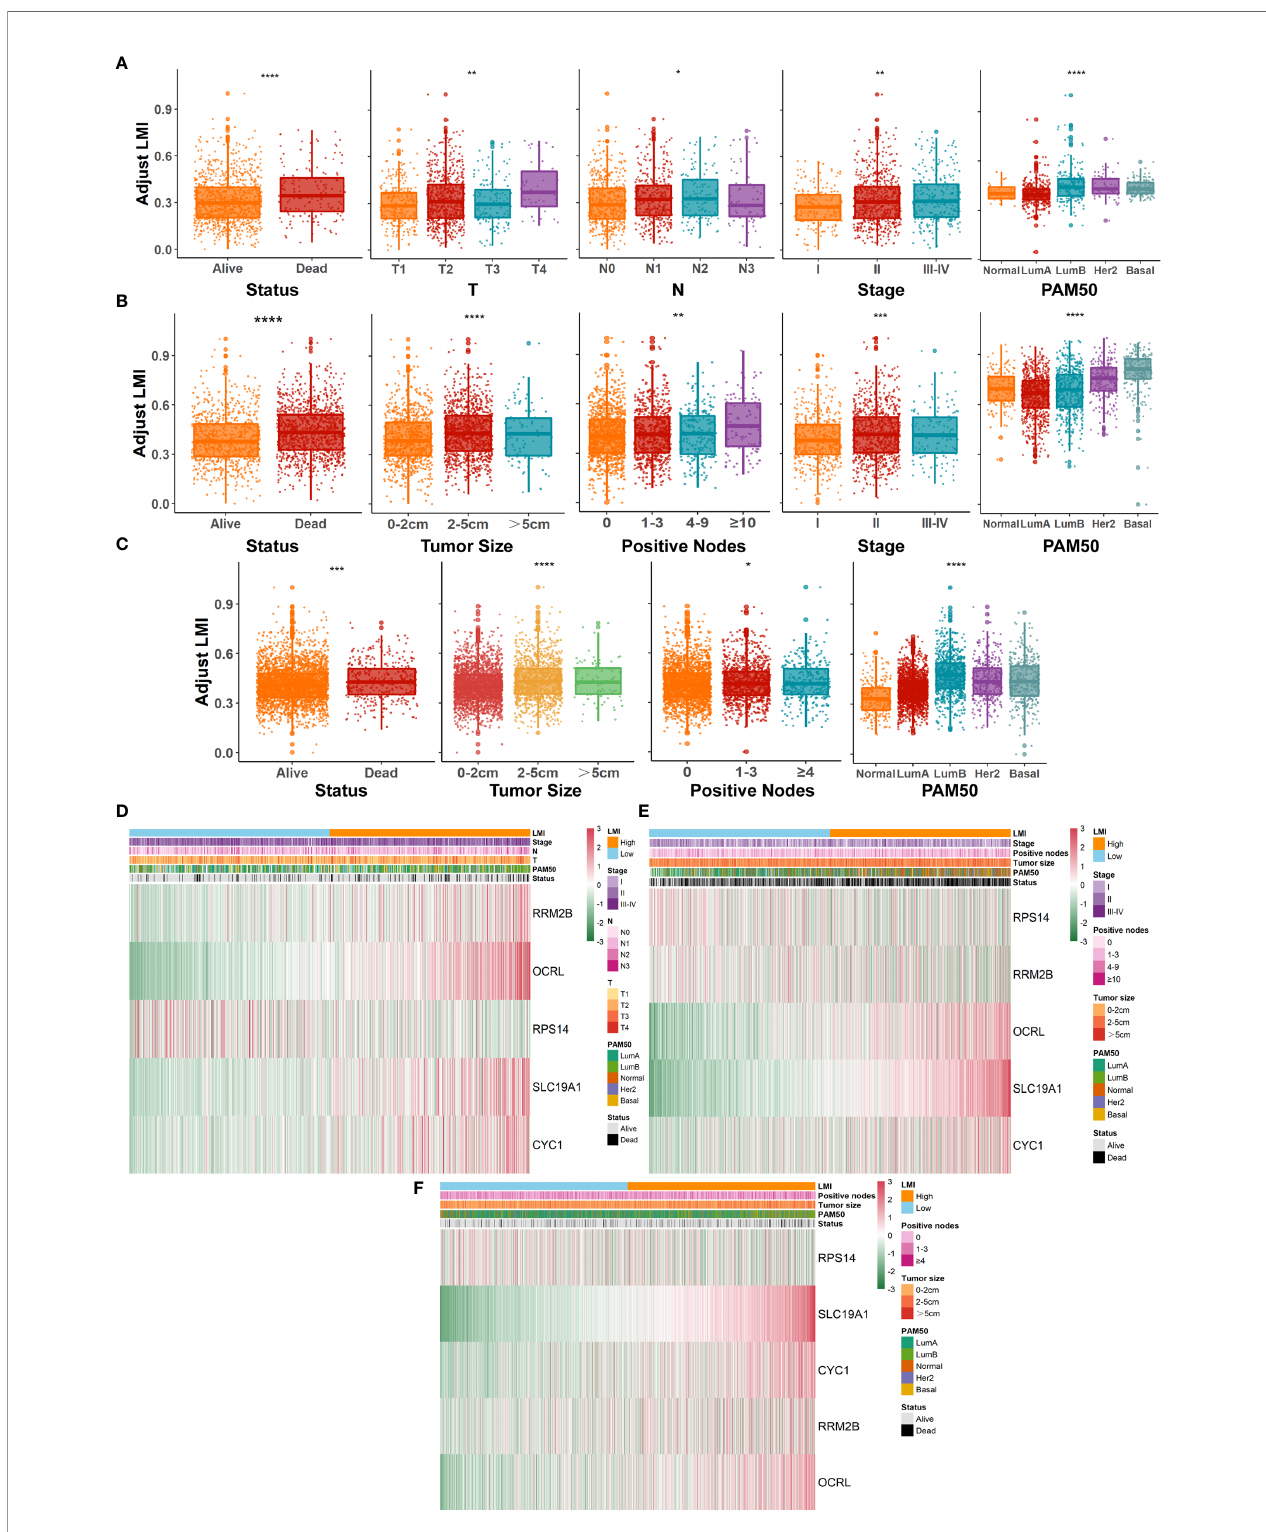
FIGURE 4 | Systematic dissection of LMI and clinical parameters in BC patients. The boxplots to illustrate the correlation between LMI and different clinicopathological characteristics of BC patients in TCGA-BRCA (A) , METABRIC (B) and GSE96058 (C) , respectively. Correlation heatmaps of signature-included LMGs and clinicopathological features in datasets of TCGA-BRCA (D) , METABRIC (E) and GSE96058 (F) separately. *p < 0.05; **p < 0.01; ***p < 0.001; ****p <